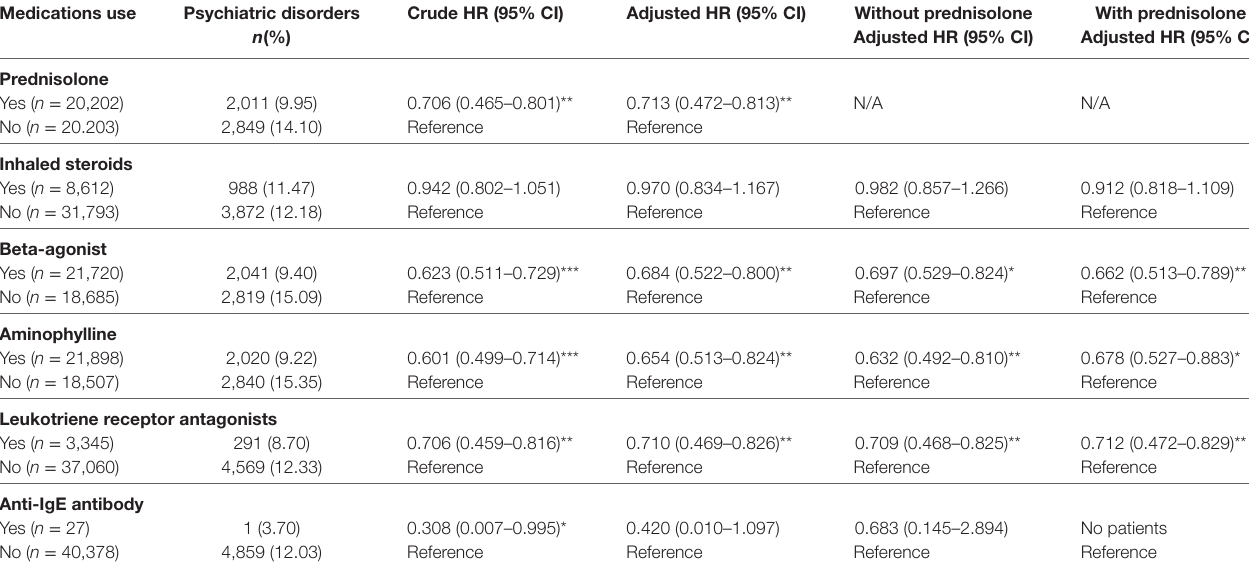
TaBle 7 | HRs of patients with psychiatric disorders by medication use compared with patients with oral prednisolone use. Medications